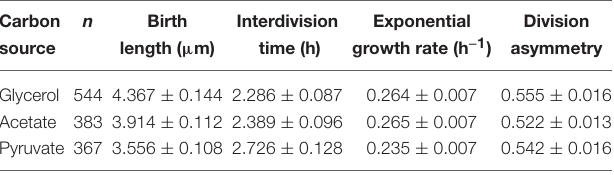
TABLE 1 | Single-cell growth parameters for M. smegmatis cells grown in various single carbon sources in a microfluidic device. Carbon